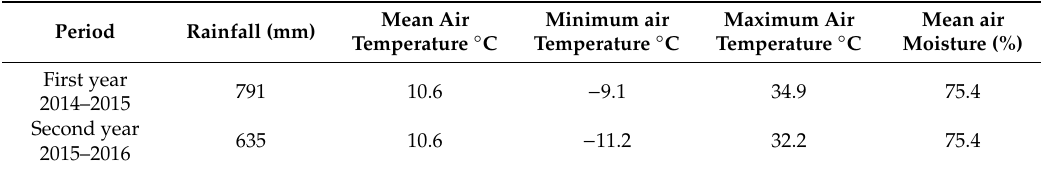
Table 2. Main climatic data recorded by the weather station of